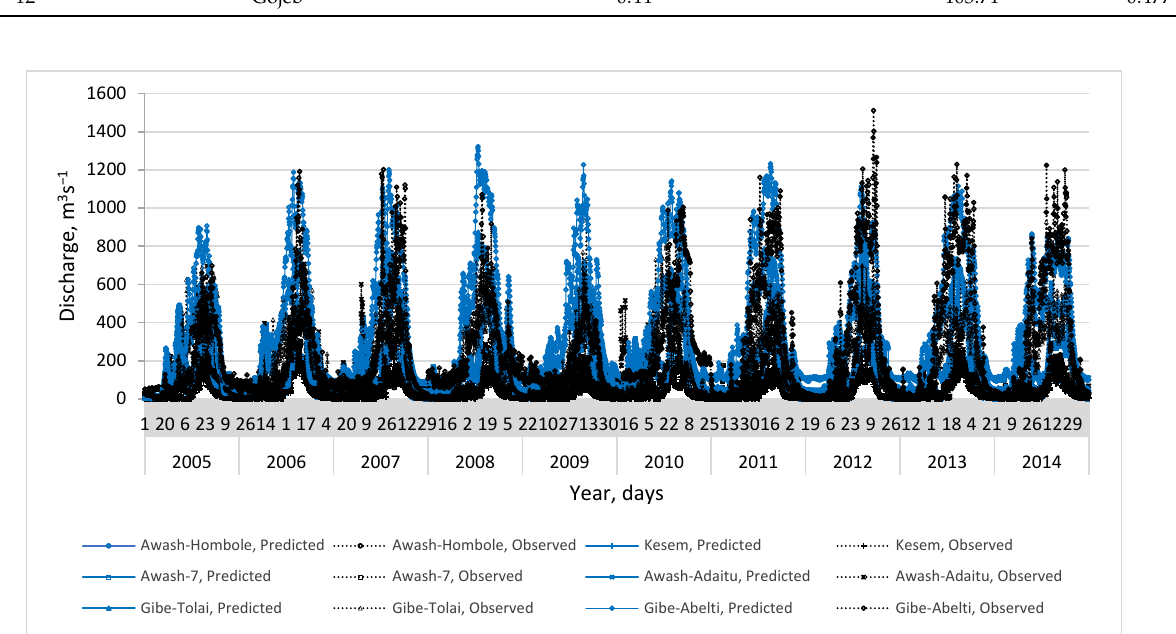
Figure 6. Observed vs. predicted runoff for selected rivers in Awash and Omo-Gibe basins.